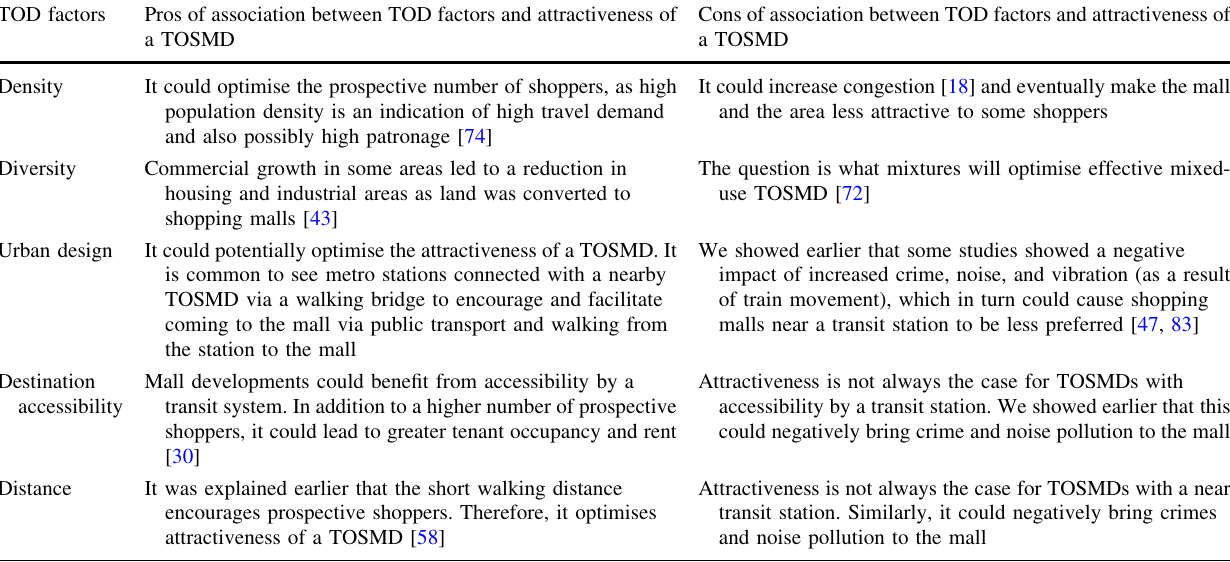
Table 4 Pros and cons of association between TOD factors and attractiveness of a TOSMD TOD factors Pros of association between TOD factors and attractiveness of a TOSMD